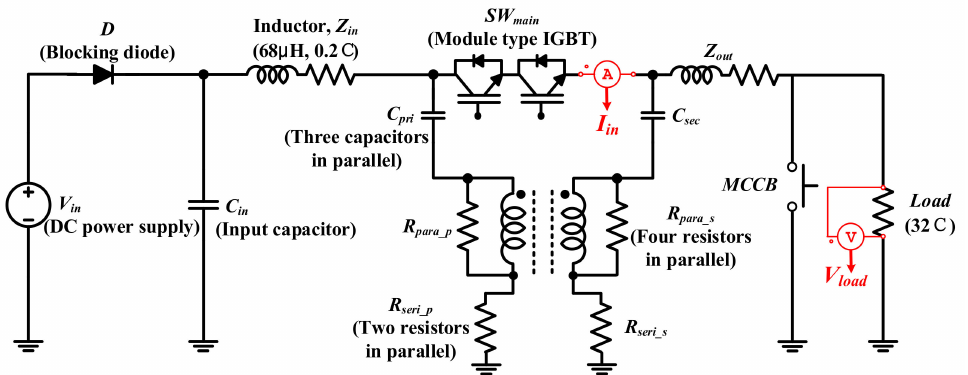
Figure 9. Test circuit schematic for the short-circuit